Question: Name the type of graph shown.
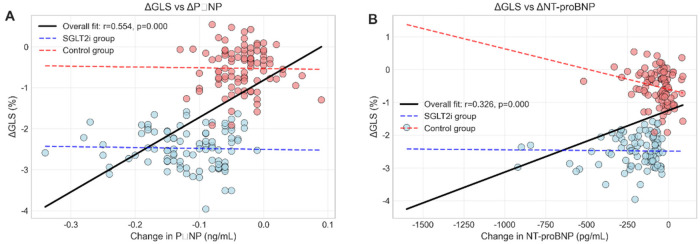
Answer: scatter